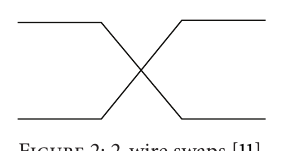
Figure 1: 2-output fan-out NAND gates.